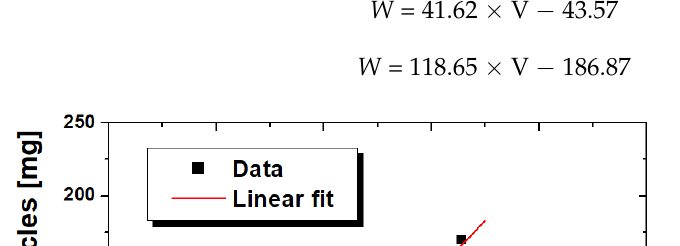
Figure 6. Standard specimens of the ferrous particles: ( a ) Fine particles; ( b ) Coarse particles.